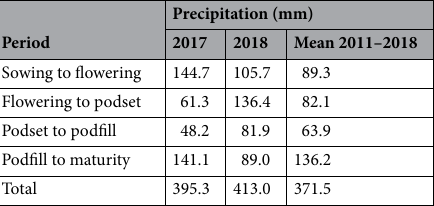
Table 1. Precipitation during the 2017 and 2018 soybean growingseasons in Hesheng Town of Gansu Province, China.